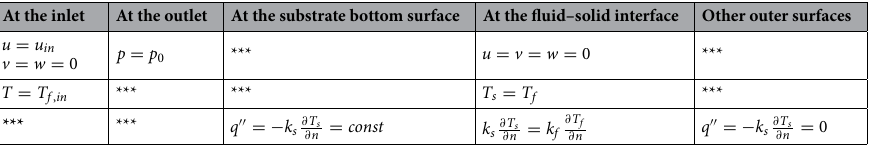
Table 4. Boundary conditions. where u , v , and w represent the components of the velocity vector in the x , y , and z directions, u in is the fluid inlet velocity, T f , in is the fluid inlet temperature, p 0 denotes the atmospheric pressure, q” indicates the heat flux exerted to the bottom surface of the substrate, T s , and T f are the solid and fluid temperatures, and n is the perpendicular direction to the surface.